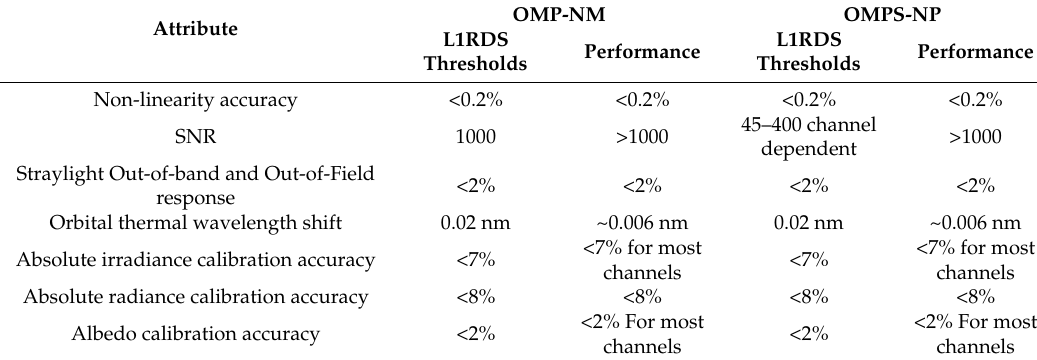
Figure 15. UV index forecast product (18 November 2016) utilizing S-NPP OMPS observations. (Figure courtesy: Craig Long, NWS). Table 14. S-NPP OMPS SDR performance.